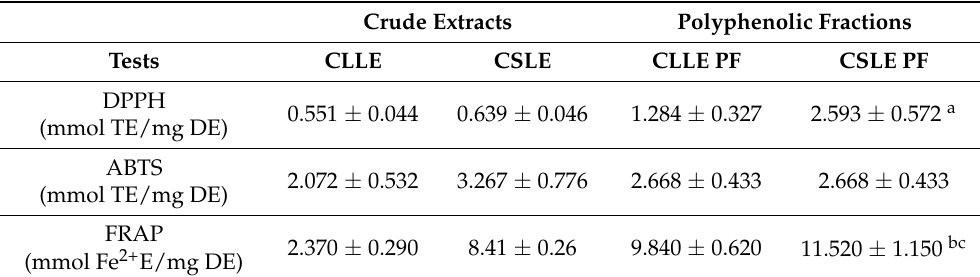
Table 3. Scavenging activity evaluation of C. laurifolius L. and C. salviifolius L. crude extracts and their polyphenolic